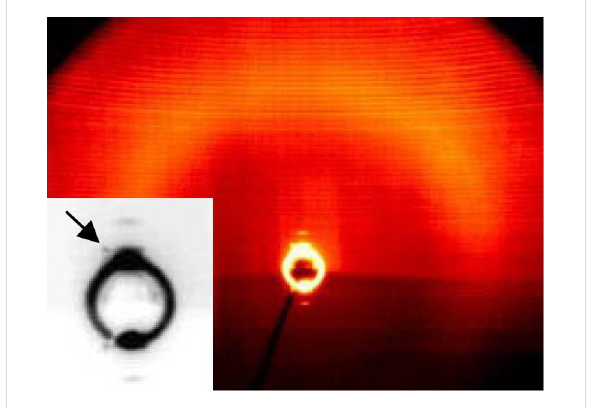
Figure 14: 2D X-ray diffraction pattern of a partially surface-aligned sample of OH 4b at 115 °C (inset: Small angle region, the arrow points to one of the additional non-layer